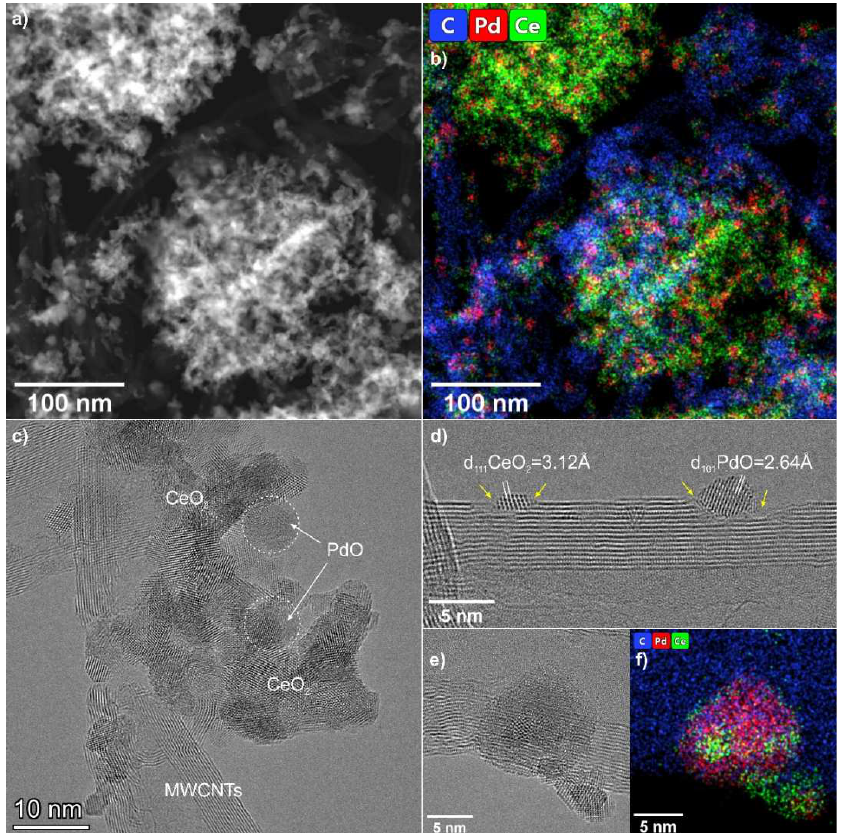
Figure 2. TEM data for Pd-Ce-C catalyst: ( a , b ) HAADF-STEM image and corresponding EDX-mapping patterns showing distribution of C (blue), Pd (red) and Ce (green); ( c – e ) HRTEM images; ( f ) EDX-mapping patterns for the region shown in panel ( e ). The EDX maps are presented in background-corrected intensities.